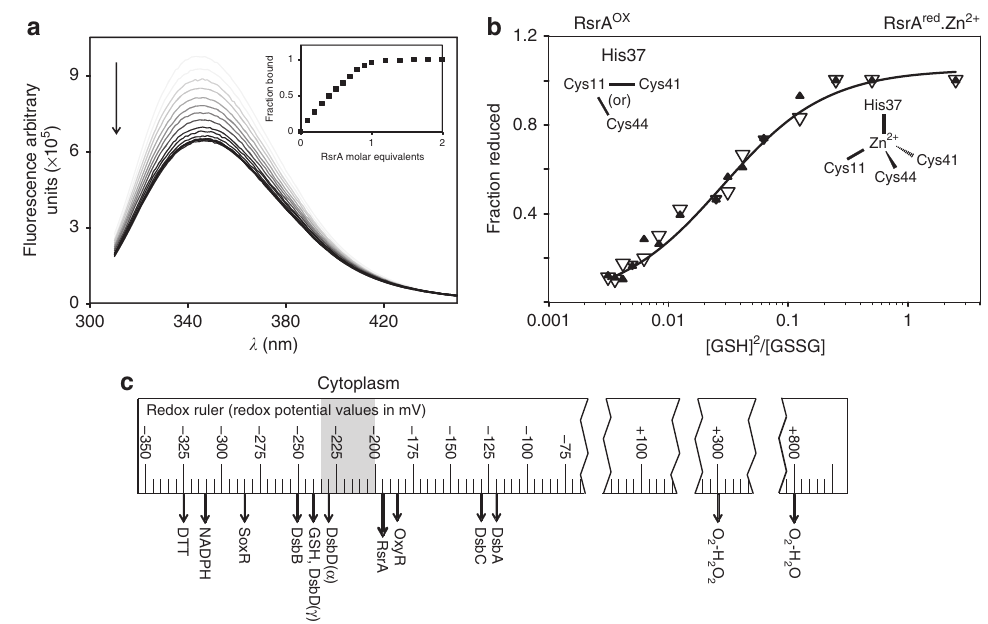
Figure 2 | Redox potential of the RsrA red .Zn 2 þ – r R complex. ( a ) RsrA red .Zn 2 þ binding to s R monitored by intrinsic tryptophan emission fluorescence spectroscopy. Figure shows emission spectra ( l ex 295nm) of s R at different RsrA red .Zn 2 þ concentrations collected at 25 (cid:2) C in 50mM Tris (pH 7.5) buffer, 100mM NaCl and 2mM DTT. For clarity, traces are coloured with incrementally darker tone of grey for increasing RsrA concentration. Inset figure shows fraction of s R in complex as measured by the change in fluorescence intensity at 343nm with increasing RsrA red .Zn 2 þ concentration. Data show stoichiometric binding of RsrA red .Zn 2 þ to s R . ( b ) Redox potential of RsrA red .Zn 2 þ in complex with s R complex relative to a redox couple of reduced/ oxidized glutathione. The degree of oxidation was measured by the change in tryptophan emission fluorescence of s R as the complex dissociates (open triangles) and by the release of Zn 2 þ using the PAR assay (filled triangles). Both sets of data were fitted to the Nernst equation to determine the redox potential of the RsrA red -Zn 2 þ – s R complex as (cid:2) 193.04 ± 2.01mV. Experiments were conducted in 50mM Tris (pH 7.5) buffer containing 100mM NaCl and at 25 (cid:2) C. ( c ) Redox ruler showing the redox potentials of selected proteins and small molecules. Figure adapted from ref. 27. The estimated redox potential of the bacterial cytoplasm is indicated in grey.